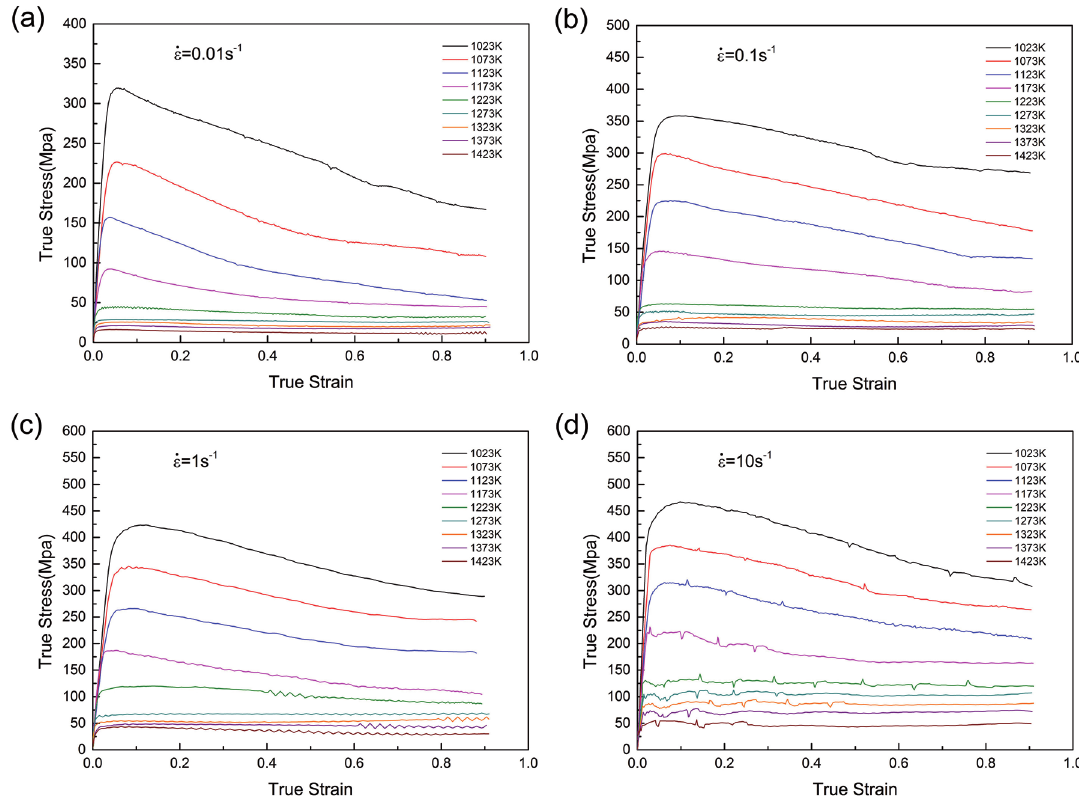
Figure 3: The true strain-stress curves of titanium alloy Ti-6Al-4V-0.1Ru at different temperatures and strain rates: (a) f o =0.01 s -1 ; (b) f o =0.1 s -1 ; (c) f o =1 s -1 ; (d) f o =10 s -1 .